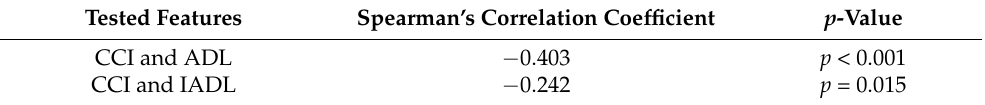
Table 4. Relationship between the severity of comorbidities (CCI) and the ADL and IADL scores. Tested Features